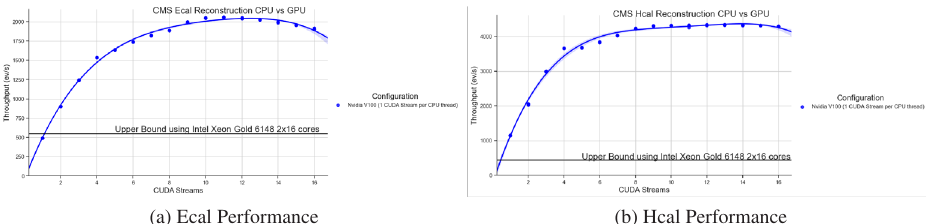
Figure 4: Ecal (a) and Hcal (b)